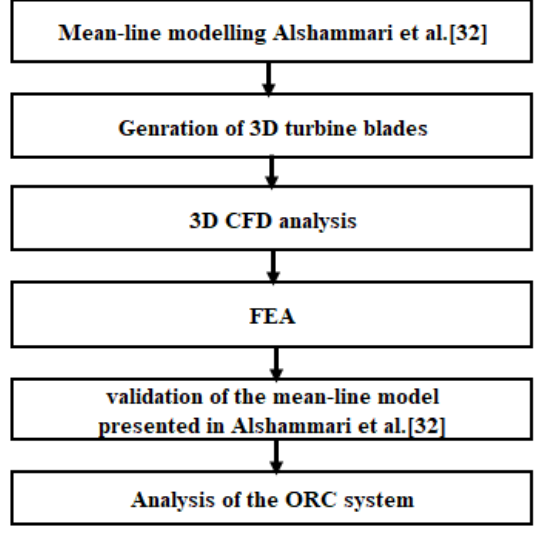
Figure 1. Flowchart of the present study.